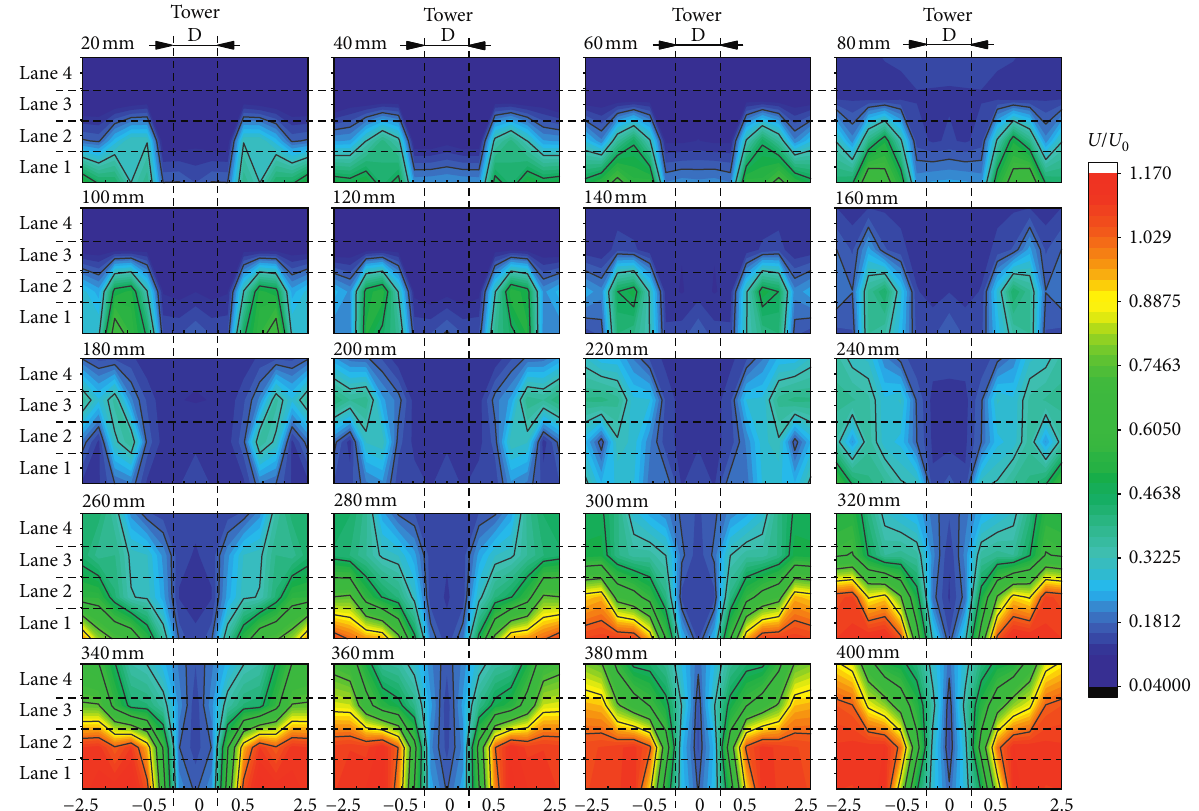
Figure 8: Contours of wind field above the bridge deck in the presence of WB-1 Figure 10 at a height of 280 mm above the deck. At a low